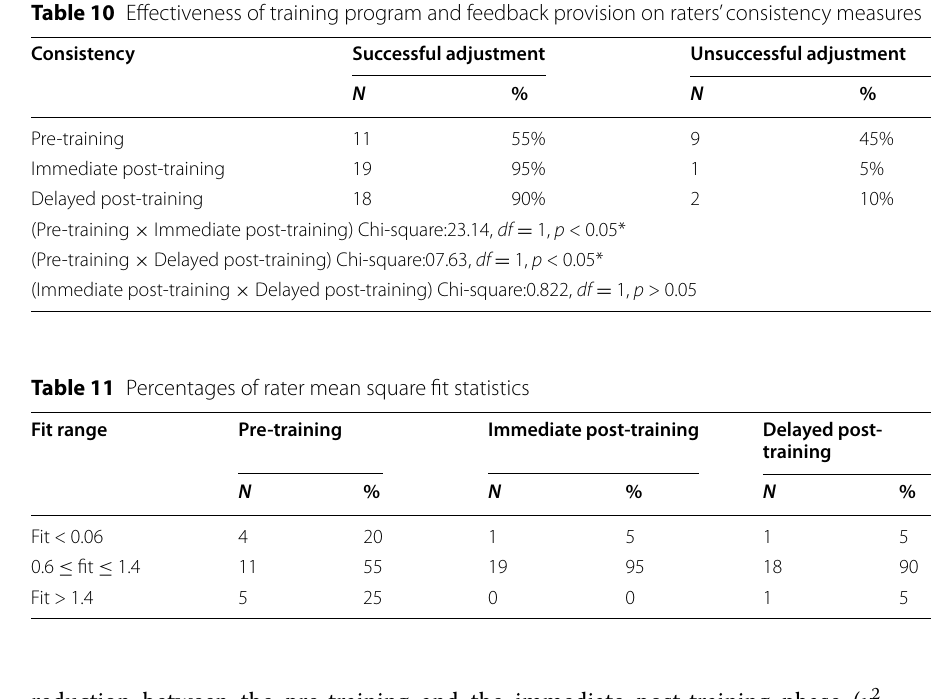
Table 10 Effectiveness of training program and feedback provision on raters’ consistency measures Consistency Successful adjustment Unsuccessful adjustment N % N % Pre‑training 11 55% 9 45% Immediate post‑training 19 95% 1 5% Delayed post‑training 18 90% 2 10%